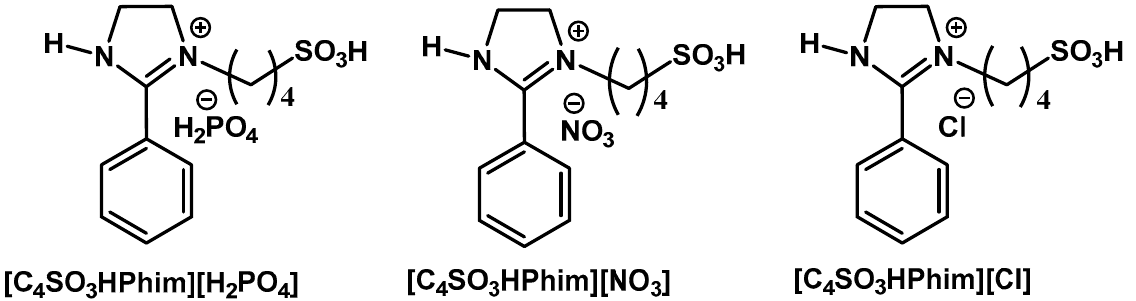
Figure 7. Structure of the ionic liquid catalyst used in this study for glucose conversion to levulinic acid (LA).